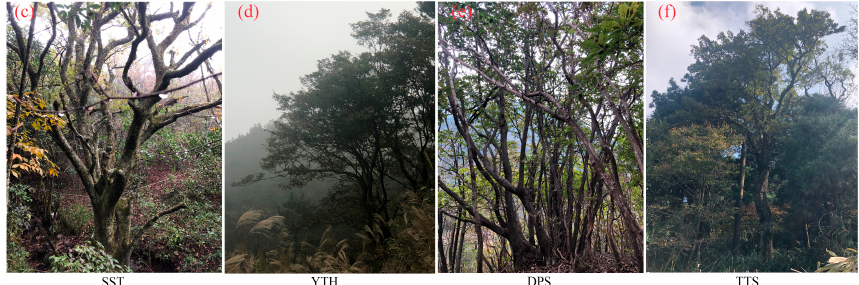
Figure 1. Current locations of Carpinus tientaiensis populations in China. ( a ) Geographic locations of C. tientaiensis populations in China; ( b ) the geographical location of C. tientaiensis in Zhejiang Province; ( c – f ) field photos of C. tientaiensis located in Shangshantou (SST) in Jingning She Autonomous county, Yangtianhe (YTH) in Qingtian county, Dapan mountain (DPS) in Pan’an county and Tiantai mountain (TTS) in Tiantai county, respectively. ZJ: Zhejiang province; JH: Jinhua city; TZ: Taizhou city; LS: Lishui city. (The field pictures of C. tientaiensis were taken by R.Z.).